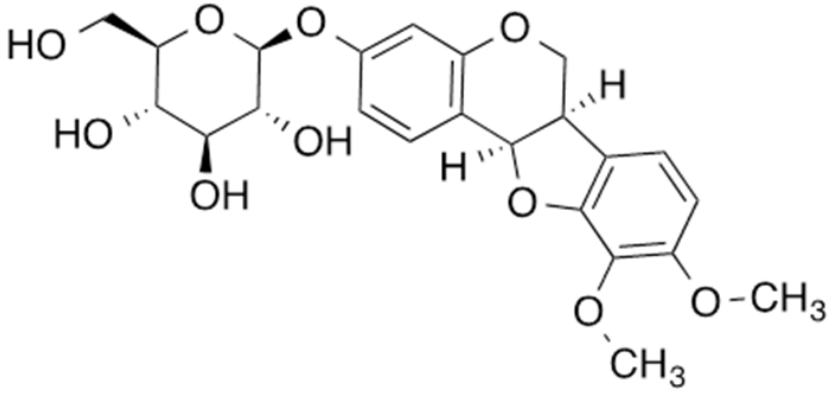
Figure 1. Chemical structure of